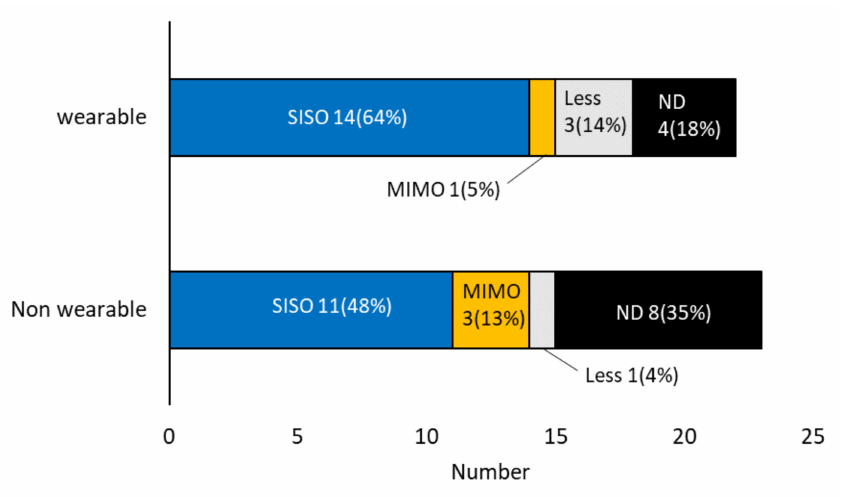
Figure 7. Summary of the system